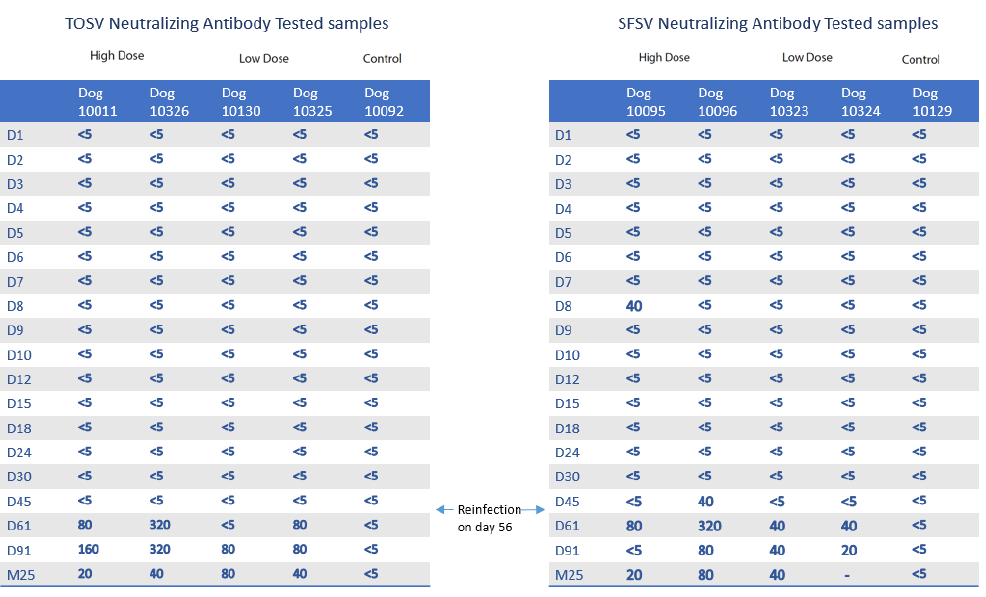
Figure 3. Temporal dynamics of positive neutralizing antibody titers in TOSV- and SFSV-inoculated dogs. M25 = 760